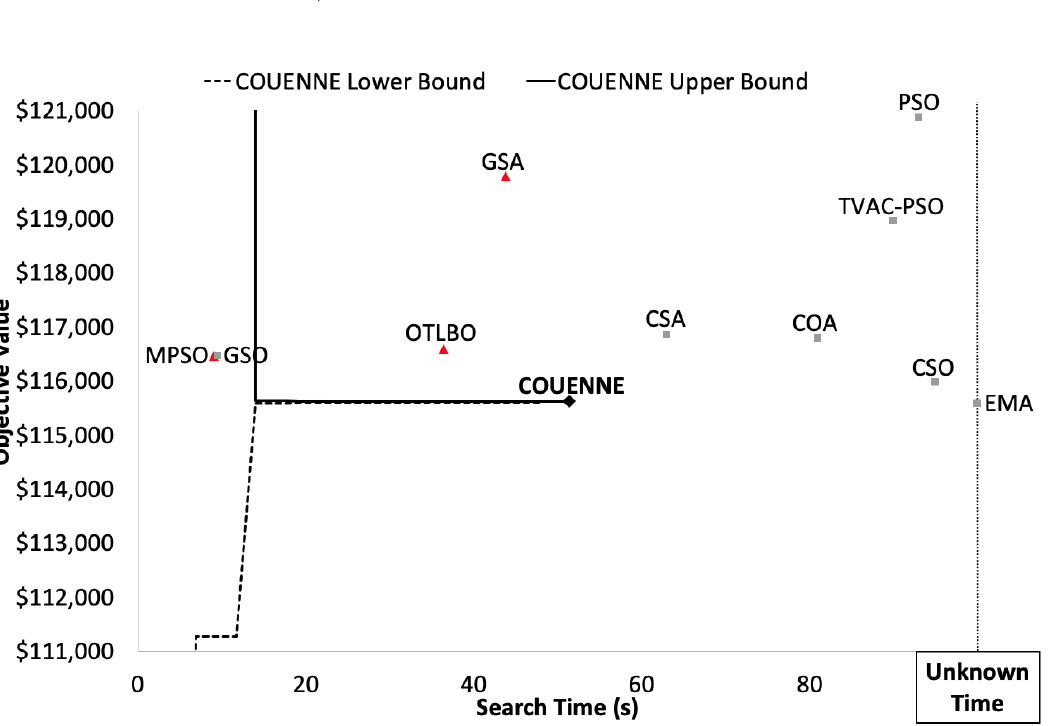
Figure 5. Search progression of COUENNE compared with optimal values obtained using metaheuristic search algorithms for test instance 5. Red triangles represent solutions which violate generating unit operating